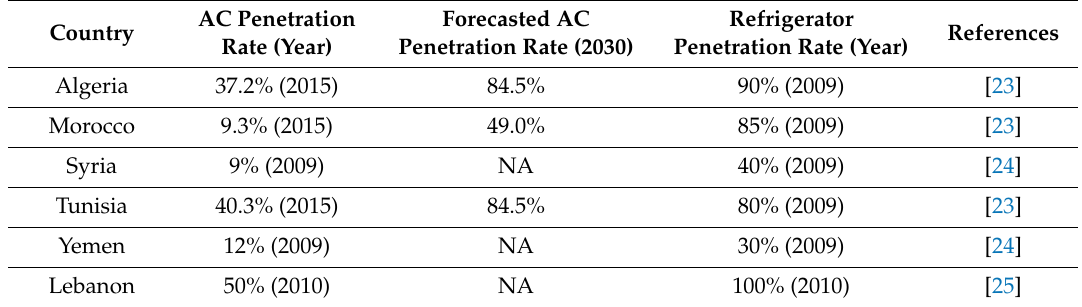
Table 5. Penetration rates of air conditioning (AC) systems and refrigerators in residential buildings for some Arab countries.